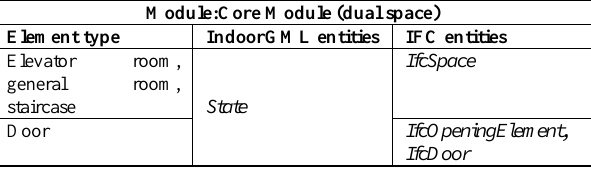
Table 1. Entity relationship between IFC and IndoorGML (modified from Kim et al., 2014)